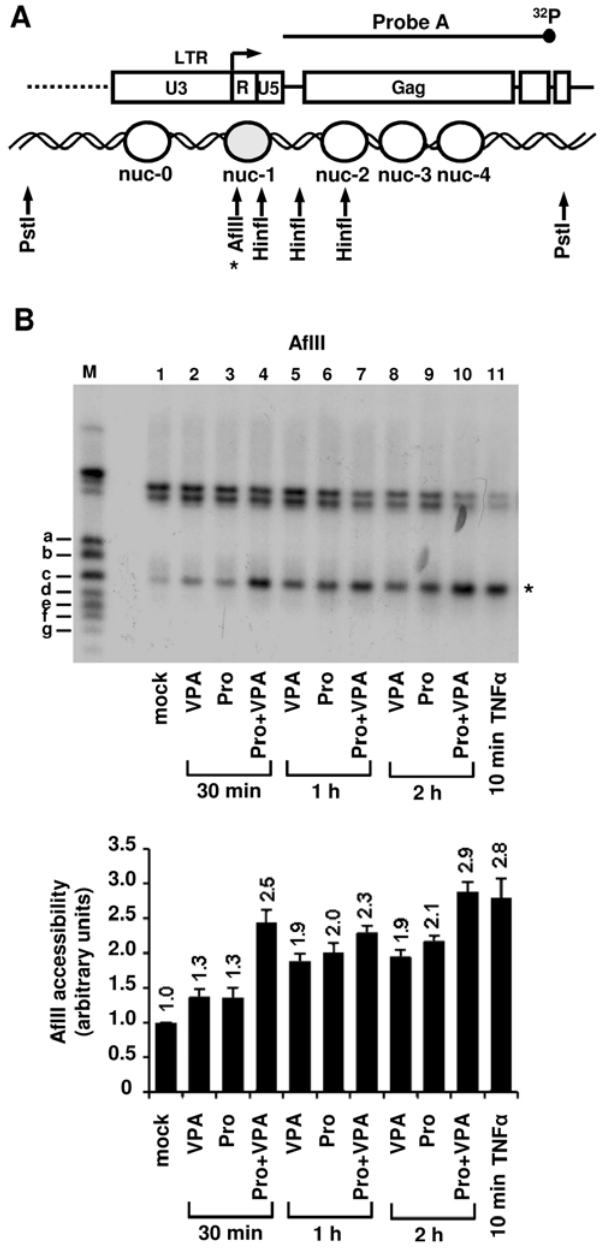
Figure 6. Remodeling of nuc-1 after prostratin + VPA versus VPA treatment. ( A ) Diagram indicating the positions of nucleosomes in the 5 9 portion of the HIV-1 genome, the HinfI and AflII (*) cutting sites and the probe used in indirect end-labeling. An asterisk, representing the AflII cutting site, is located next to the band on the gel to permit its identification. ( B ) Nuclei were prepared from U1 cells mock-treated or treated with TNF a (10 ng/ml) (10 min), prostratin (5 m M), VPA (2.5 mM) and prostratin + VPA for 30 min, 1 h or 2 h and digested with AflII. After DNA purification and in vitro restriction with PstI, DNA samples were analyzed by indirect end-labeling using probe A (top panel) [93]. Size markers (a, b, c, d, e, f, g) have been previously described [93]. Quantification of the PstI-AflII bands was performed by radioimaging analysis using an InstantImager (Packard) (bottom panel) and results are presented as histograms indicating the band intensities relative to the intensity observed with mock-treated U1 cells, which was arbitrarily assigned a value of 1. Each value is the mean 6 SE of three separate experiments performed in duplicate.